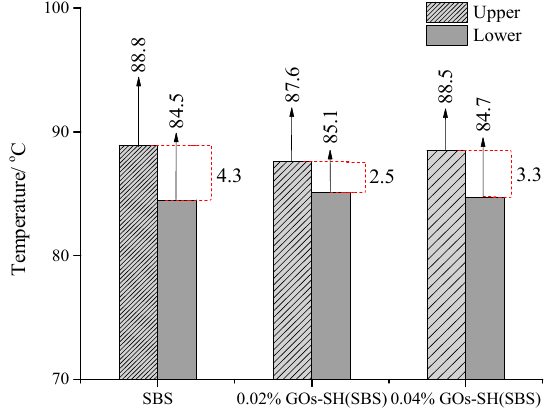
Figure 10. Test results of segregation experiment for various asphalt groups.